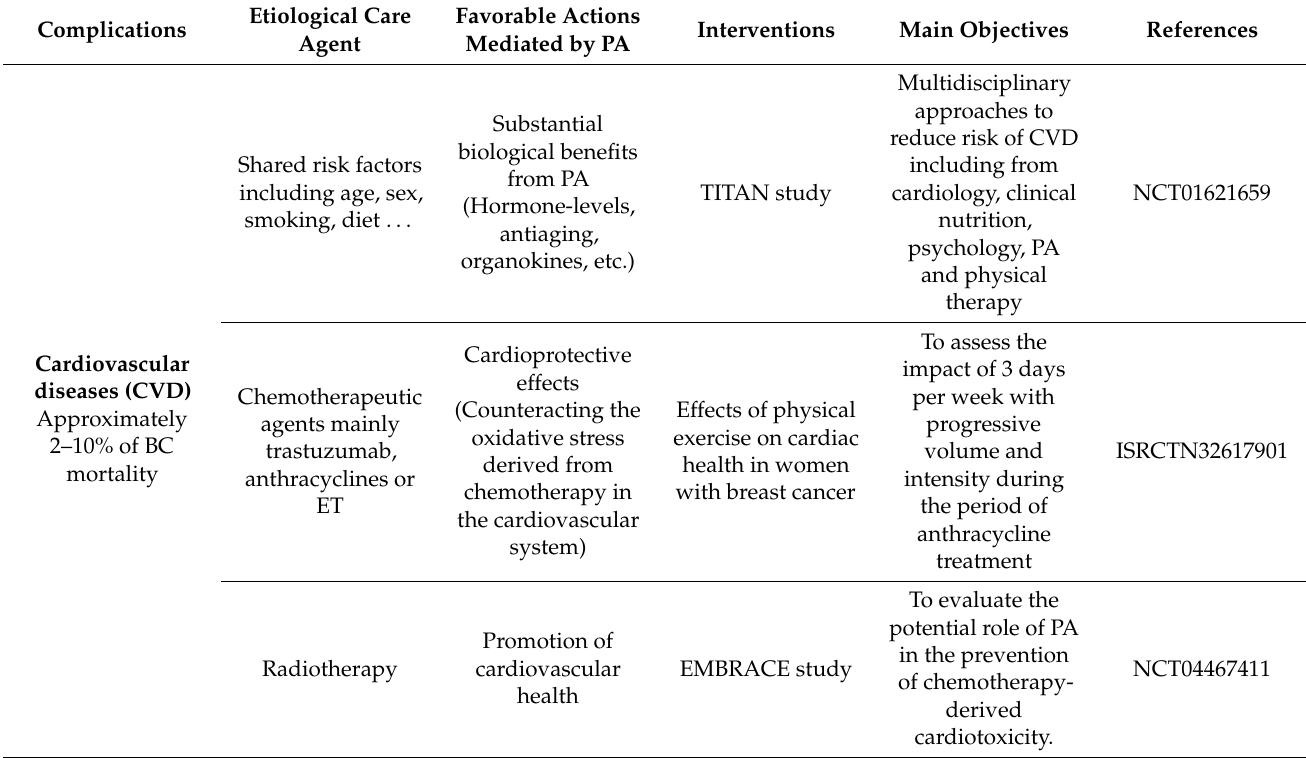
Table 1. Potential examples and mechanisms of Physical Activity (PA) benefits in different therapies-derived adverse effects.